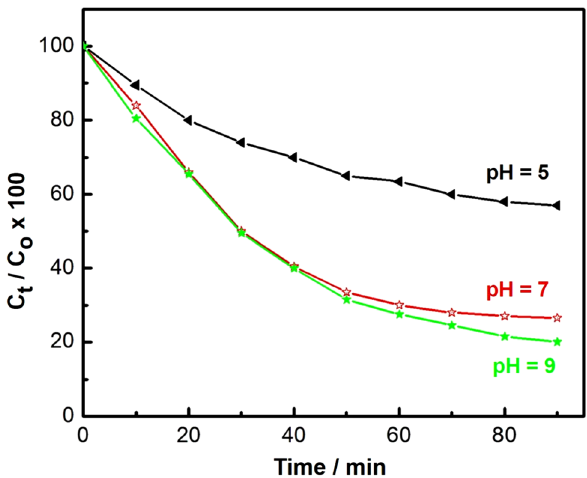
Figure 13. Effect of pH on the degradation of chloramine-T (10 mg nanocomposite, 50 ml chloramine-T (20 mg/l) and 100 min